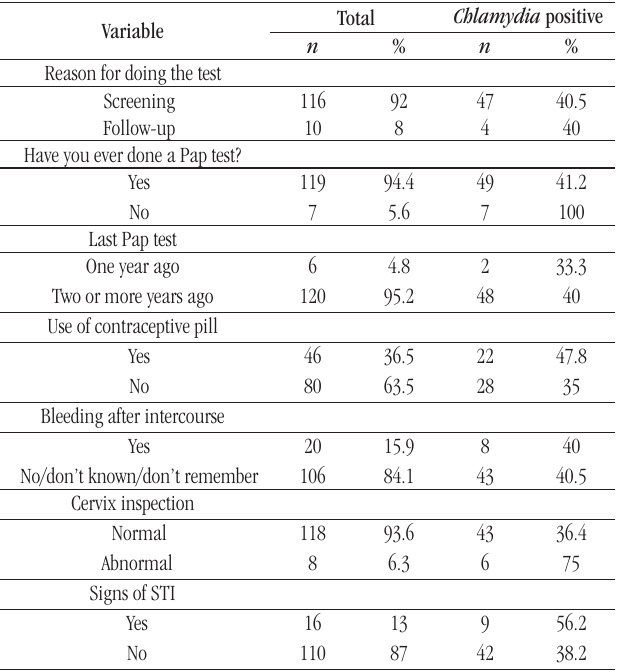
table – Information about the participants based on the SISCAN questionnaire and the incidence of Chlamydia trachomatis in endocervical samples. There was no significant difference between means ( p > 0.05)